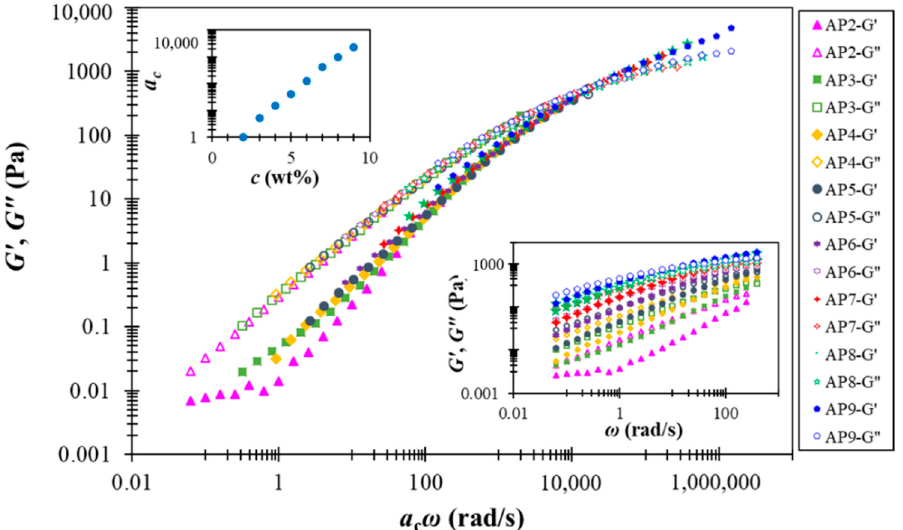
Figure 4. Time-concentration superposition of rescaled dynamic modulus data for AP hydrocolloids in this study. The lower (right) inset presents the original (un-shifted) data, and the upper (left) one shows the shift factor ac as a function of AP concentration.